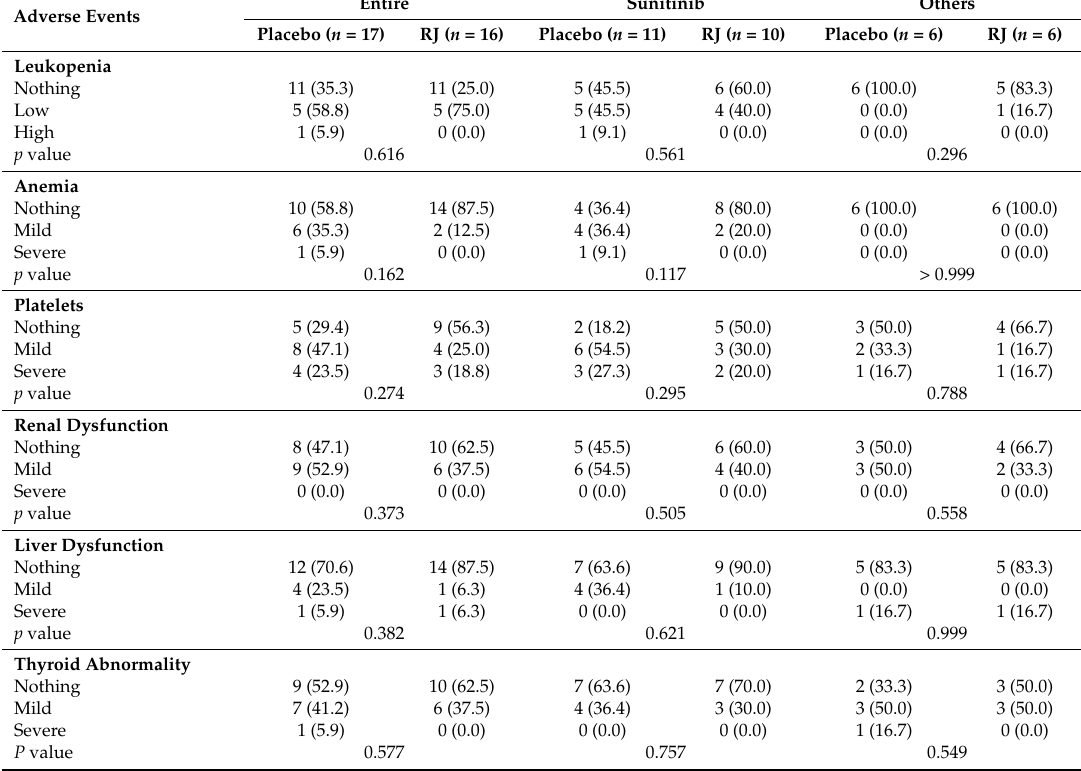
Table 4. Relationships between royal jelly intake and results of blood examinations.